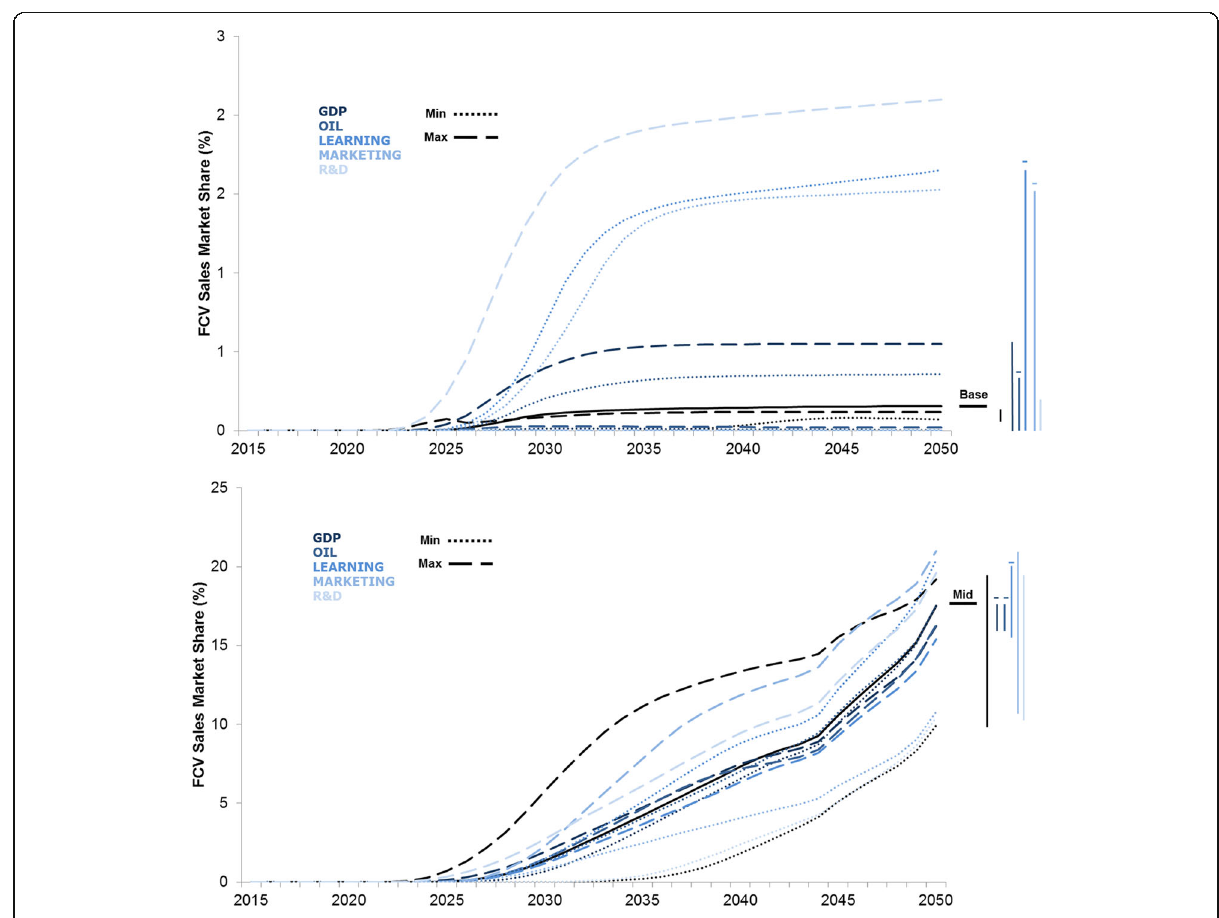
Fig. 5 EU28 FCV sales share to 2050 under Base (top) and Mid (bottom) fleet emission targets, showing range between Min and Max